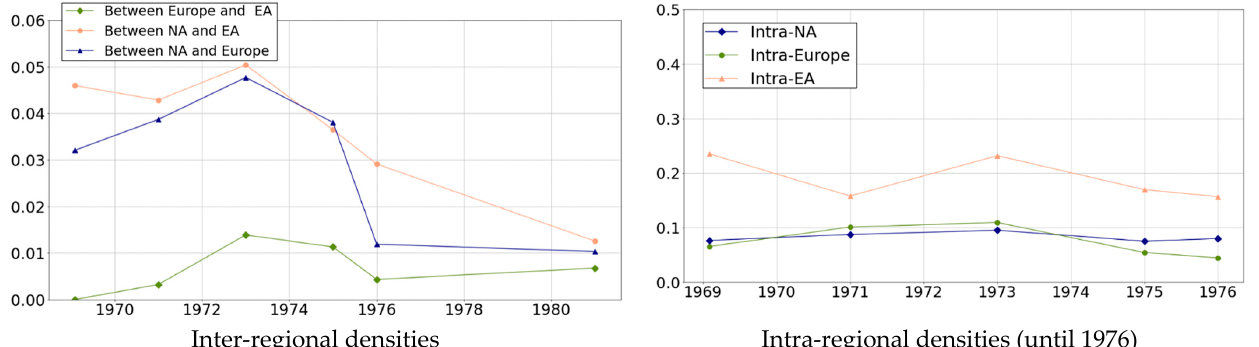
Figure 10. Inter-regional and intra-regional densities of major regions in the GDL-1 model network (1969–1981).